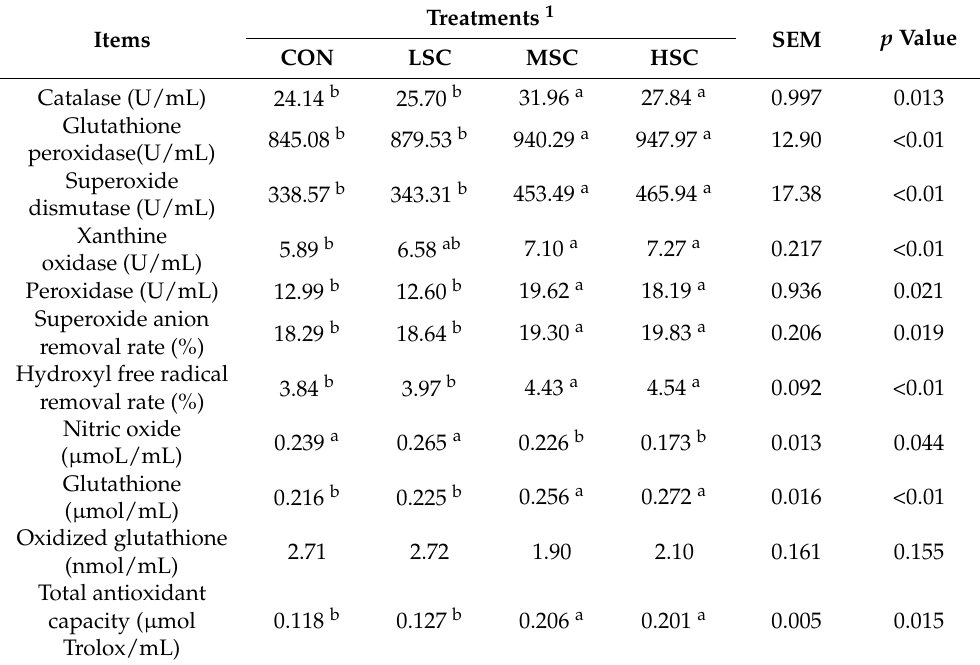
Table 5. Effects of yeast iron on serum antioxidant function of weaned